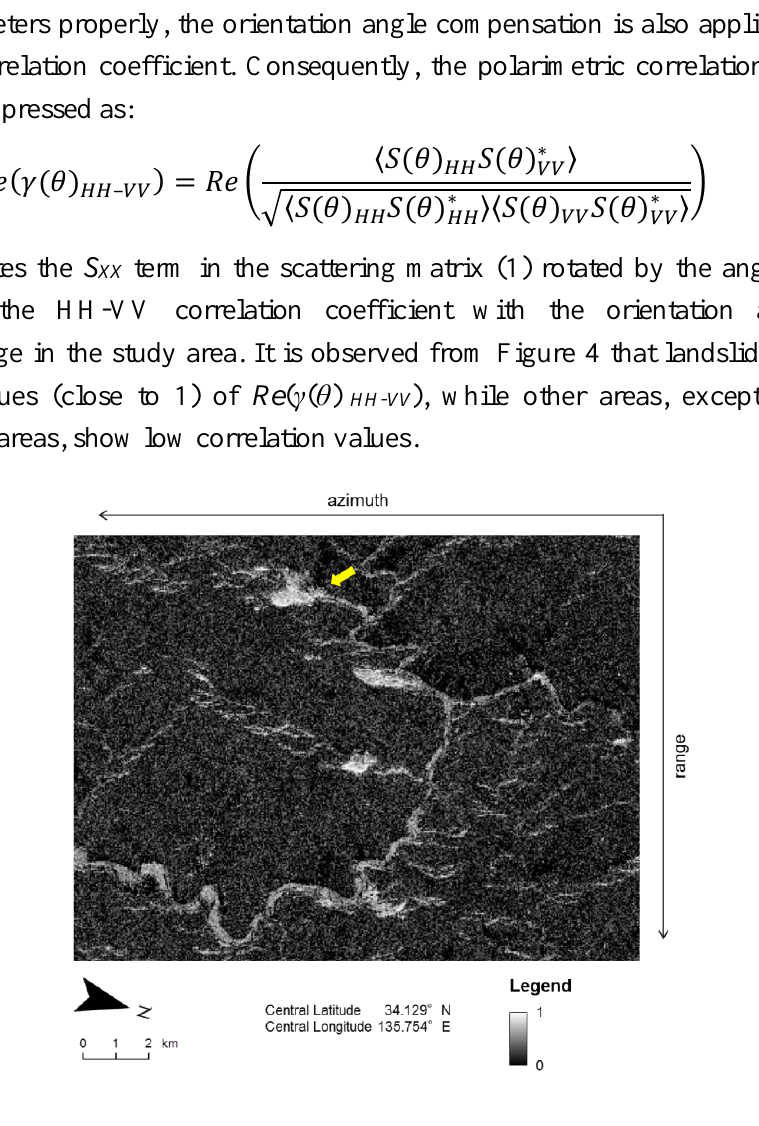
Figure 4. The gray-scaled image of the HH-VV correlation coefficient with orientation angle compensation. The image coverage and utilized PolSAR data are the as same as Figure 2. Most of the whitish portions indicate landslides or river bed. The yellow arrow on the top of the image depicts the line of sight of the optical image of a landslide (Figure